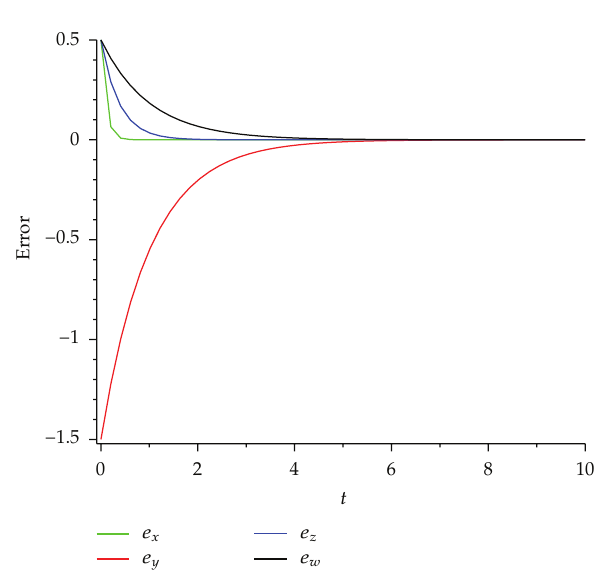
Figure 5: It shows that the behaviour of the trajectories e x , e y , e z , and e w of the hyperchaotic Lorenz system error system tends to zero as t tends to 5 when the scaling factor α (cid:8) 5.